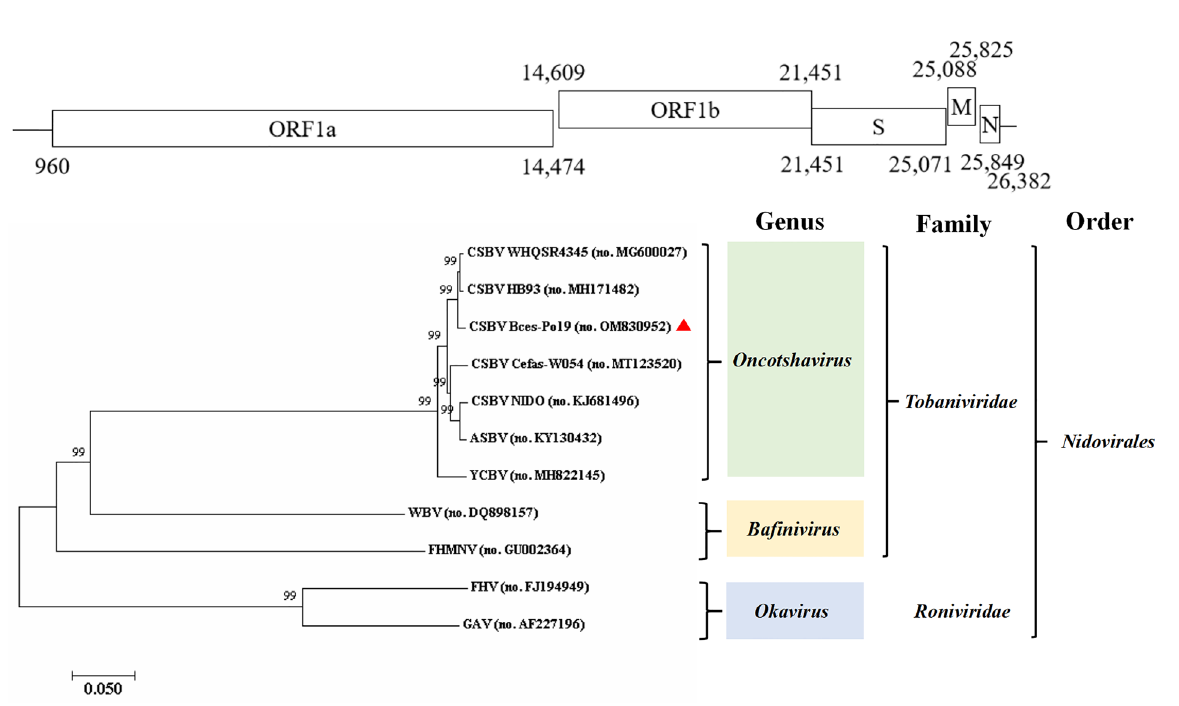
Figure 3. The genetic characteristics of CSBV Bces-Po19. ( A ) Structural organization of the CSBV Bces-Po19 genome. ( B ) Phylogenetic analysis of CSBV Bces-Po19 and other aquatic nidoviruses.